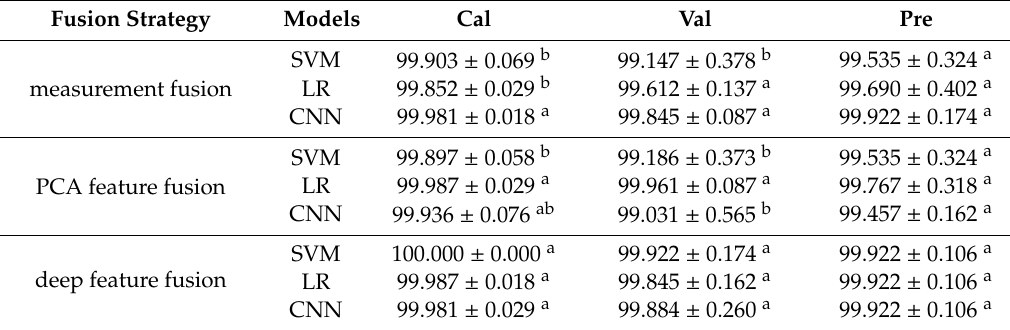
Table 4. The results of the classification models based on fusion